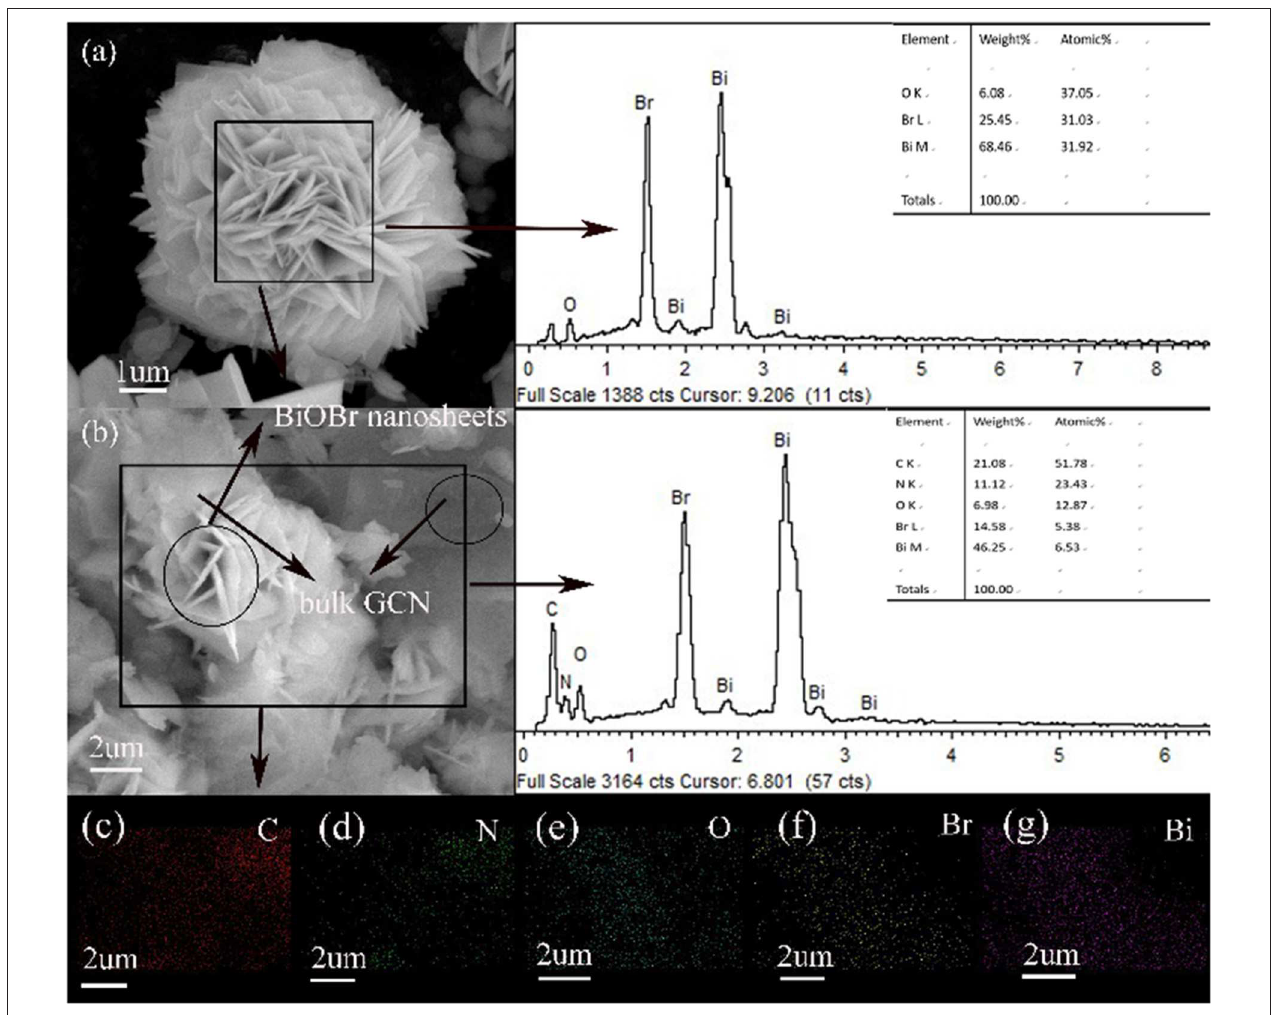
FIGURE 2 | SEM images of (a) pure BiOBr and (b) BiOBr-g-C 3 N 4 -4:1, elements mapping of BiOBr-g-C 3 N 4